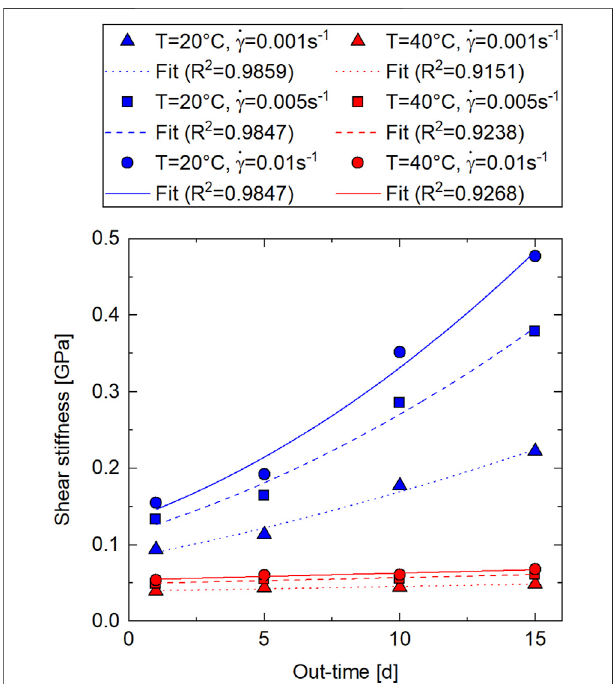
FIGURE 10 | In-plane shear modulus results as a function of out-time from rheometer torsion bar tests (Material: IM7/8552 prepreg; out-time: 1 day – 15 days at T (cid:1) 21 ° C , RH (cid:1) 40 %